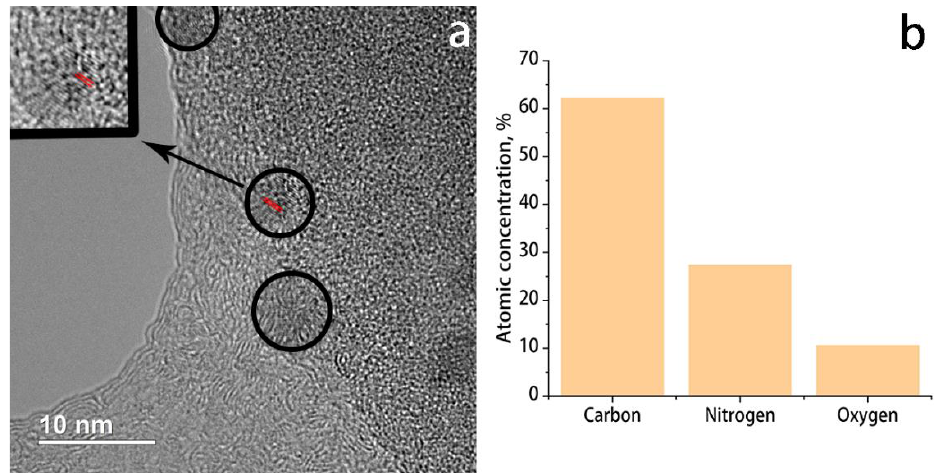
Figure 1. STEM image of the synthesized nanoparticles ( a ) and their elemental analysis ( b ). As can be seen from the presented image, the synthesized nanoparticles are about 7 nm in size. The lattice fringes are clearly visible (Figure 1, inset, red lines) with the lattice parameter around 0.189 nm that corresponds to the (102) lattice fringes of